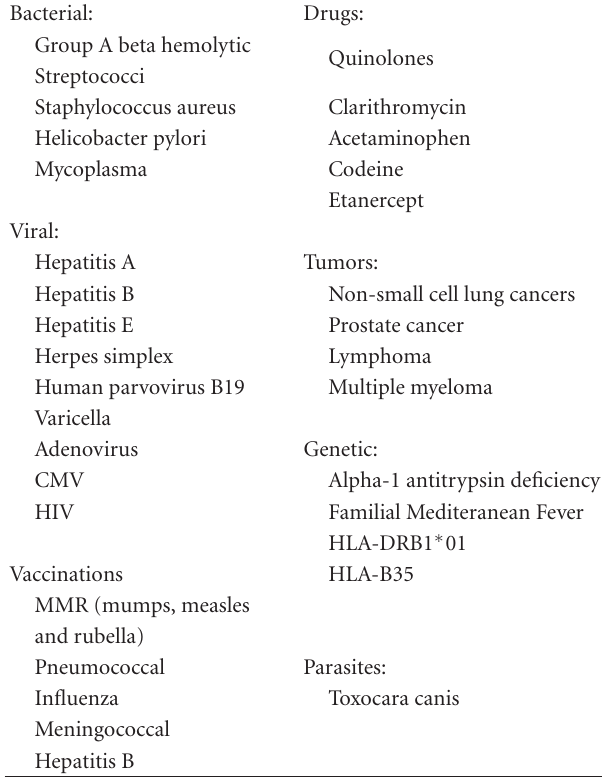
Table 1: Etiology associations with HSP